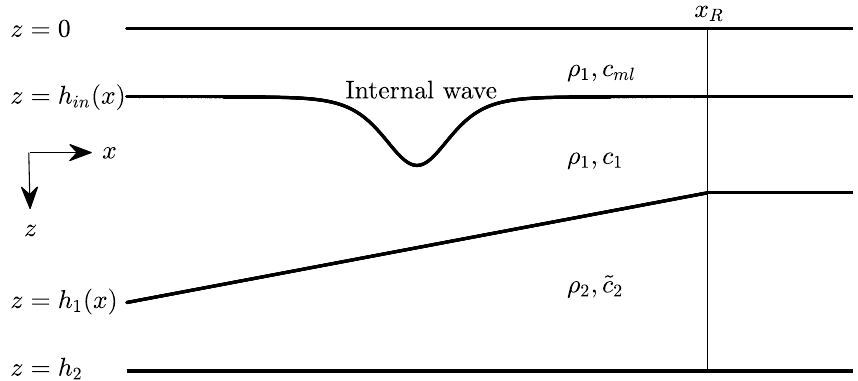
Figure 4. Approximation model for a waveguide with an internal solitary wave and a penetrable infinite homogeneous half